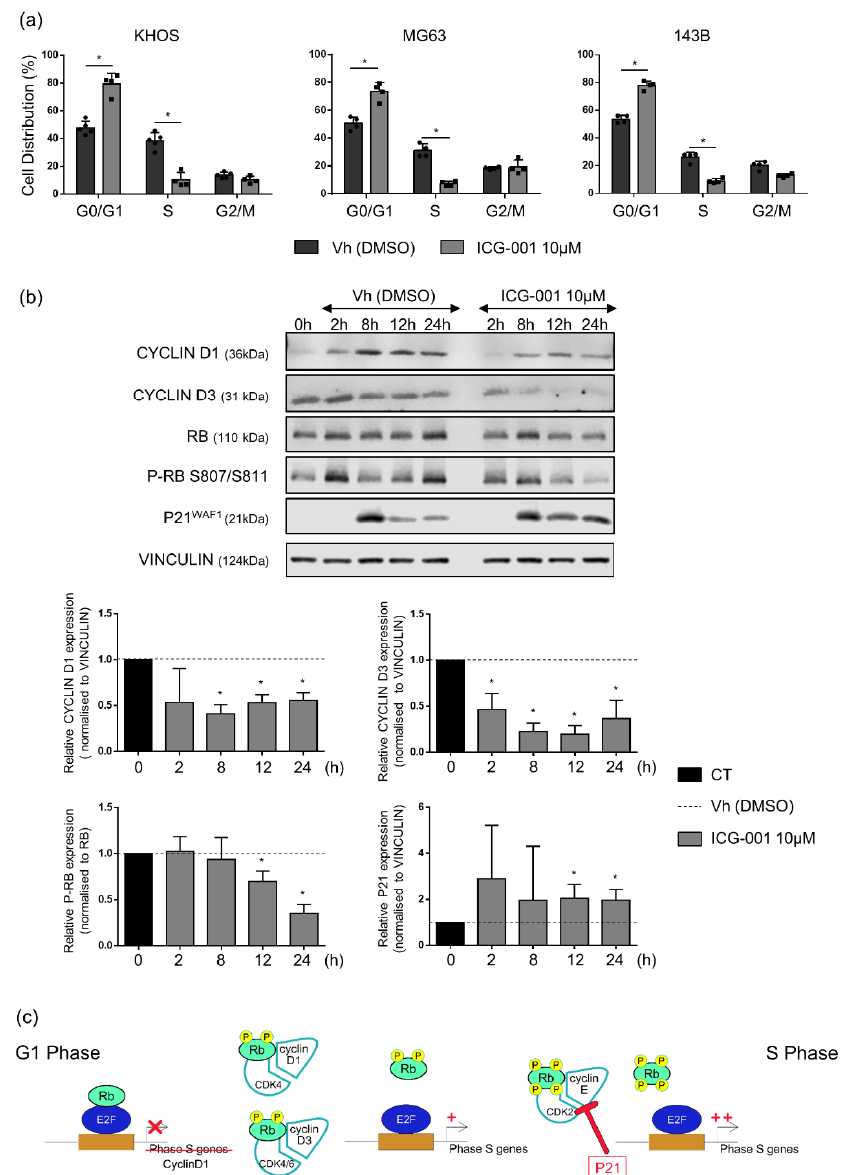
Figure 4. ICG-001 blocks KHOS, MG63 and 143B osteosarcoma cell lines in the G0/G1 phase. ( a ) Cell cycle analysis by flow cytometry in cells treated with ICG-001 (10 µM) or vehicle (Vh) for 24 h. Histograms represent means ± SD of three independent experiments. * p ≤ 0.05. ( b ) Cell cycle regulators protein expression in KHOS cells synchronized in early S phase with thymidine treatment, released in cell cycle during 0, 2, 8, 12 and 24 h, and treated with ICG-001 (10 µM) or vehicle (Vh). Representative images of three independent experiments. Histograms represent means ± SD of relative CYCLIN D1, CYCLIN D3 and P21 protein quantification relativized with the value of the vehicle (DMSO for each time) and normalised with VINCULIN and relative quantification of RB phosphorylated form protein expression relativized with the value of the vehicle (DMSO for each time) and normalized with total RB of three independent experiments. The dashed line represents the vehicle value set to 1 for each time. * p ≤ 0.05 vs vehicle for each time. ( c ) Regulation of G1 to S phase transition implicating cyclins and cyclin dependent kinases (CDK) as well as Retinoblastoma protein (Rb) and p21.